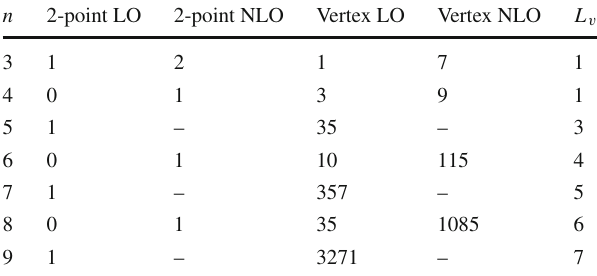
Table 1 Number of graphs computed at various orders for n given in